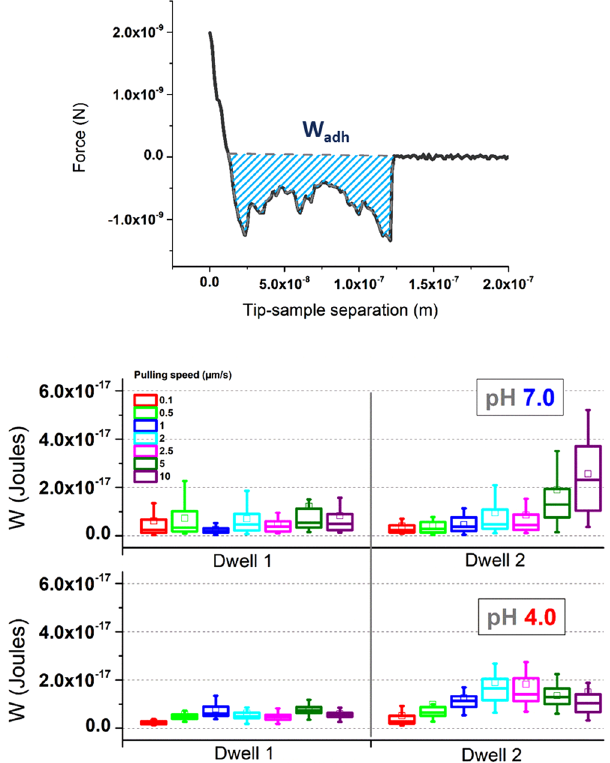
Figure 3. Work of adhesion. (Top) Representative retraction plot of mucin in pH 7. (Bottom) Chart showing the different work values of mucin under different pH, residence time and pulling speed. The square ( □ ) in the box plot represents the mean value, the box-splitting horizontal line gives the median, and the upper and lower value are indicative of the achievement of either the 99% or 1% of the population,